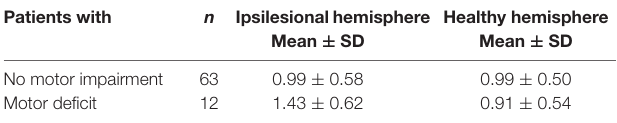
TABLE 4 | Activation peak shifts in motor deficit subgroups.